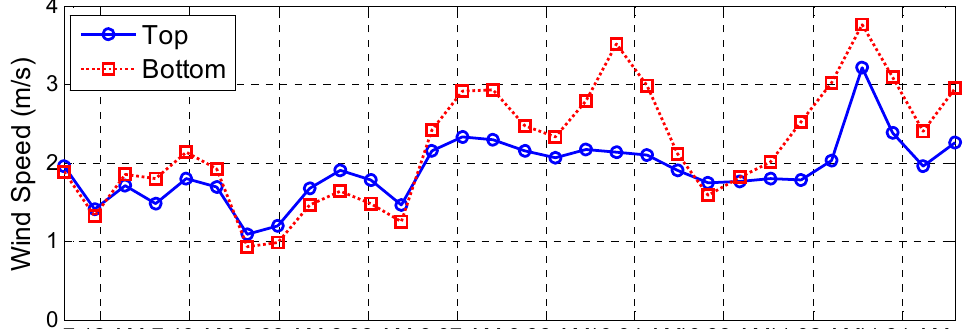
Figure 5. Wind speed measurement data at the bridge site (May 25,